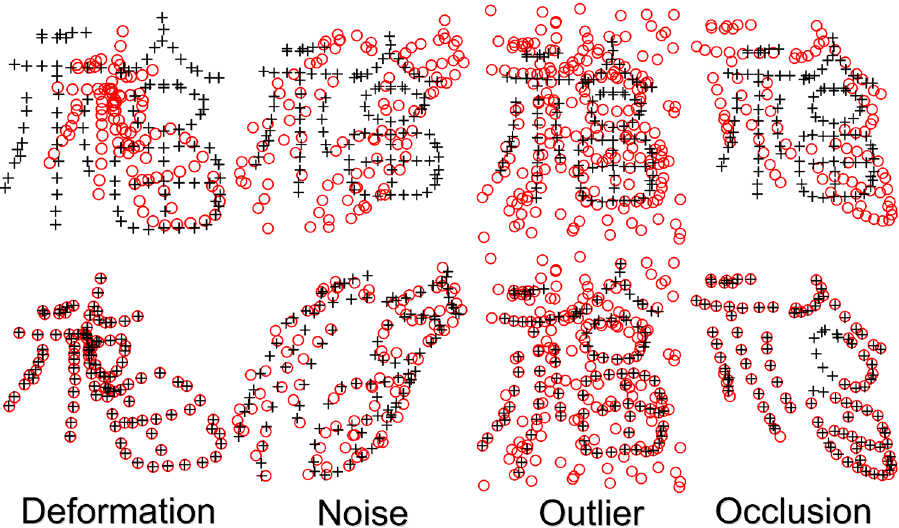
Figure 4. Performance of DSMM on 2D Chinese character shapes with deformation, noise, outlier and occlusion. We align the template point set (black “ + ”) to the target set (red “o”). For each sample, the figures in the top row show superimposed points of template point set and the target data before registration, and the figures in bottom show the registration